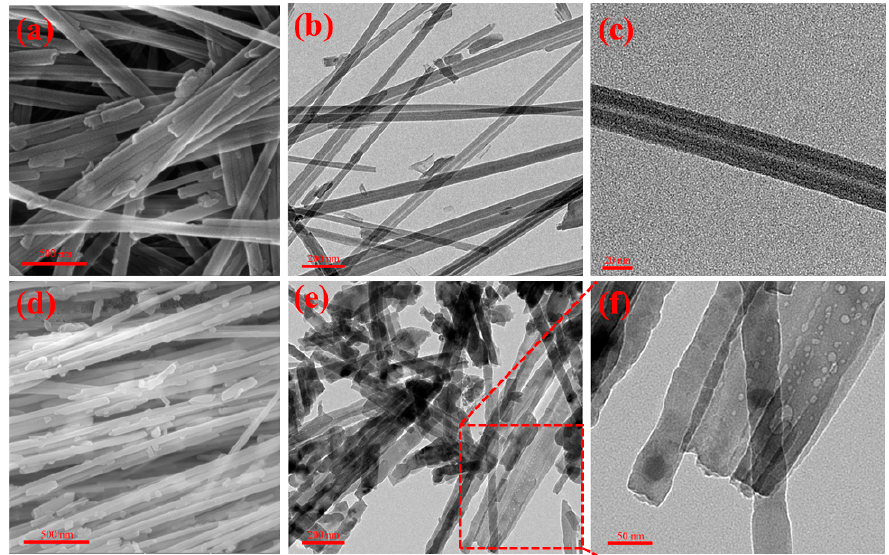
Figure 4. SEM and TEM images of raw chrysotile ( a – c ) and 850CC ( d – f ).